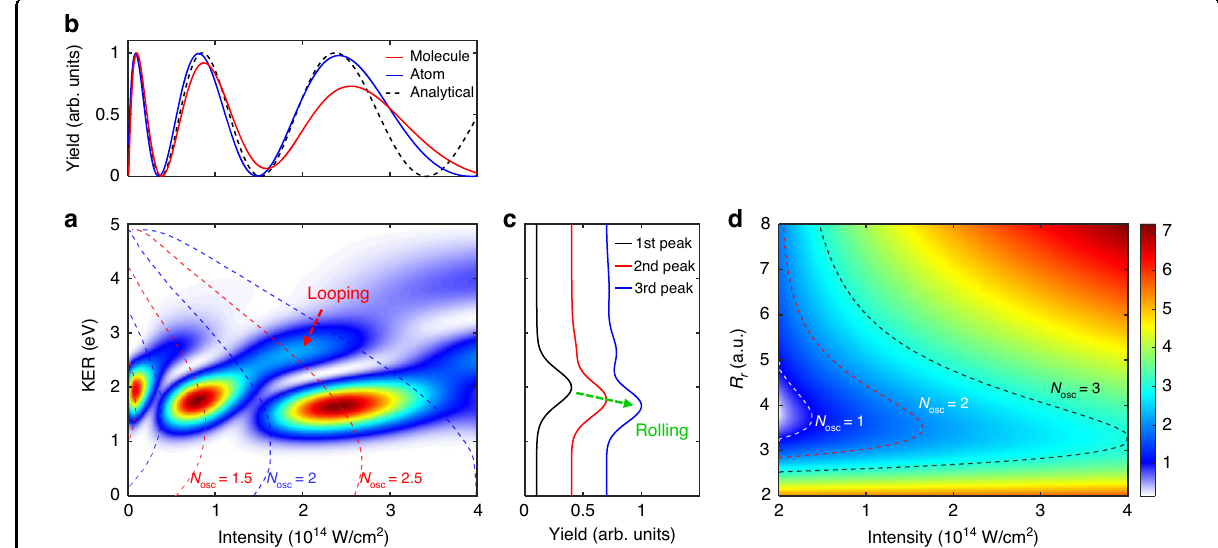
Fig. 2 Observing dynamical Rabi coupling using a few-cycle laser pulse. a The simulated KER spectra of dissociative fragments as a function of the peak intensity of a four-optical-cycle 400-nm laser pulse. Red and blue dashed curves denote the predicted KER using Eq. (3), where the molecule undergoes half-integral and integral Rabi oscillations at different internuclear distances, respectively. b Populations of the 2 p σ u state after the laser- H 2 + interaction, i.e., the proton yield, as a function of the laser intensity. The red curve is obtained by integrating the two-dimensional map in a over the region of 1.5 eV < KER < 2.5 eV. The blue curve is numerically simulated by only switching on the transition at R ω . The black dashed curve is analytically calculated using Eq. (1). The maxima of all the curves are normalized to one for the convenience of comparison. c The dissociation yields as a function of the KER obtained by integrating the two-dimensional map in ( a ) within the laser intensity regions of [0, 3.7 × 10 13 ], [3.7 × 10 13 , 1.5 × 10 14 ], and [1.5 × 10 14 , 4 × 10 14 ] W/cm 2 corresponding to the three peaks. d Number of Rabi oscillations N osc as a function of the laser intensity and internuclear distance. White, red, and black dashed curves denote the positions where N osc = 1, 2, and 3, respectively. The initial state in the calculation is the v = 6 vibrational